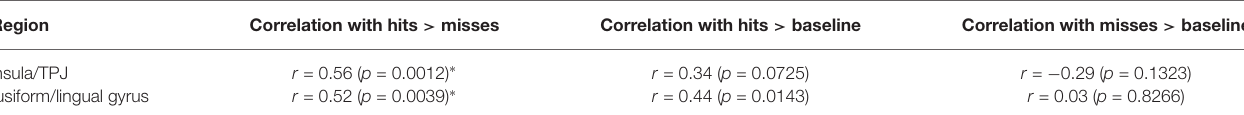
TABLE 3 | Correlations of behavioral recognition performance as assessed with SDT and fMRI activity. Region Correlation with hits > misses Correlation with hits > baseline Correlation with misses >